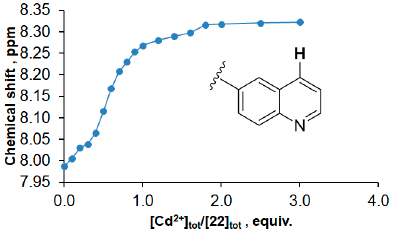
Figure 5. NMR titration of compound 22 with Cd(ClO 4 ) 2* 6H 2 O; changes in the chemical shift of the H4(Quin) proton. C L 0.036 M, C Cd(II) 0.2 M.